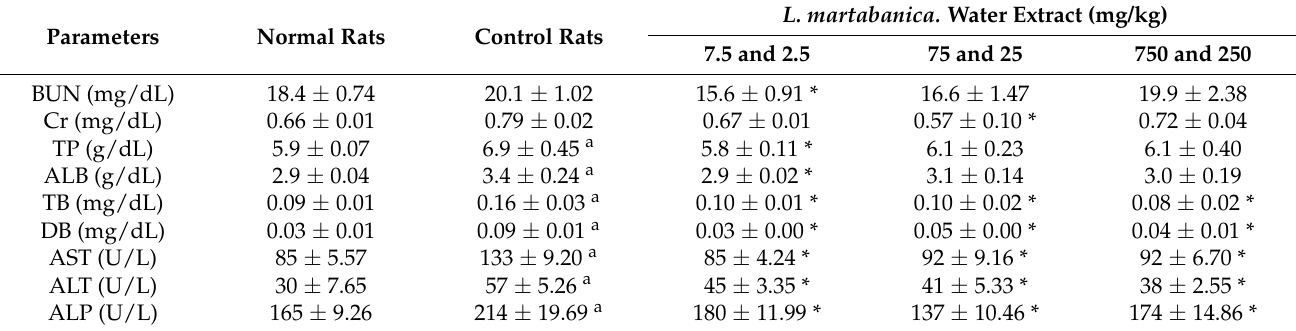
Table 6. Effect of L. martabanica water extract on the blood chemistry values of rats.